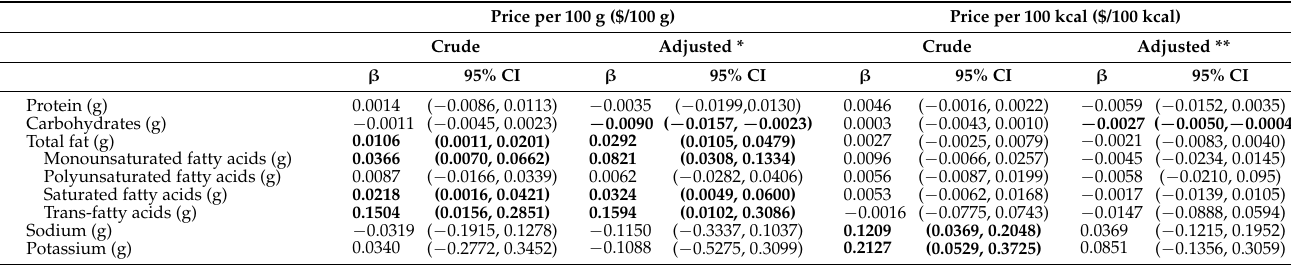
Table 3. Relation between nutrient content and food price per 100 g and per 100